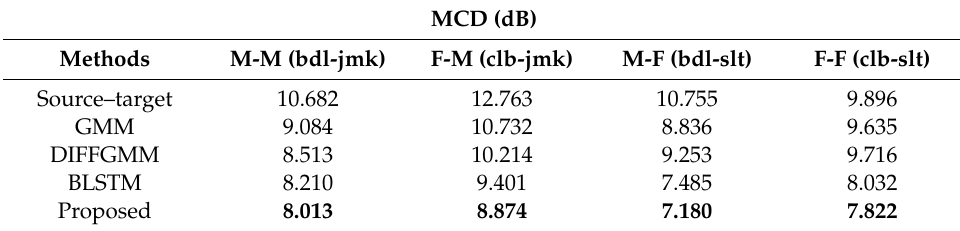
Table 1. Mean Mel-cepstral distortion (MCD) of all non-silent frames of the voice conversion (VC) methods on the CMU ARCTIC dataset (15dB babble added to source). GMM: Gaussian mixture model,